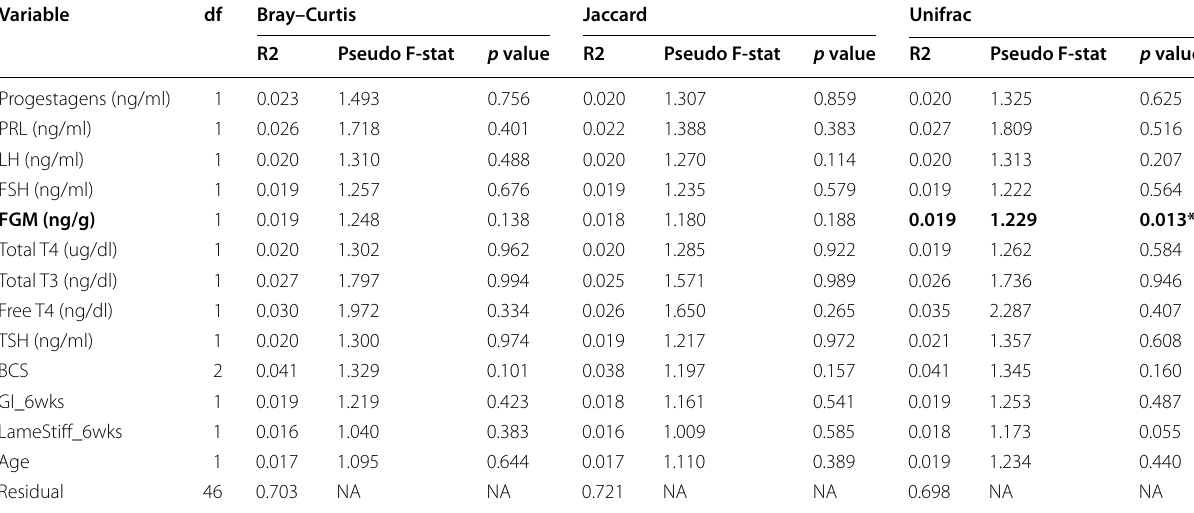
Bold text indicates variables with significant p values